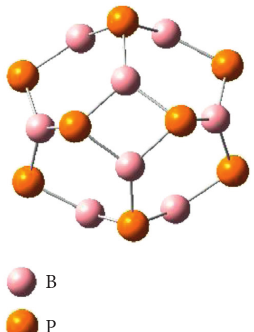
Figure 1: Optimized structure of B basis